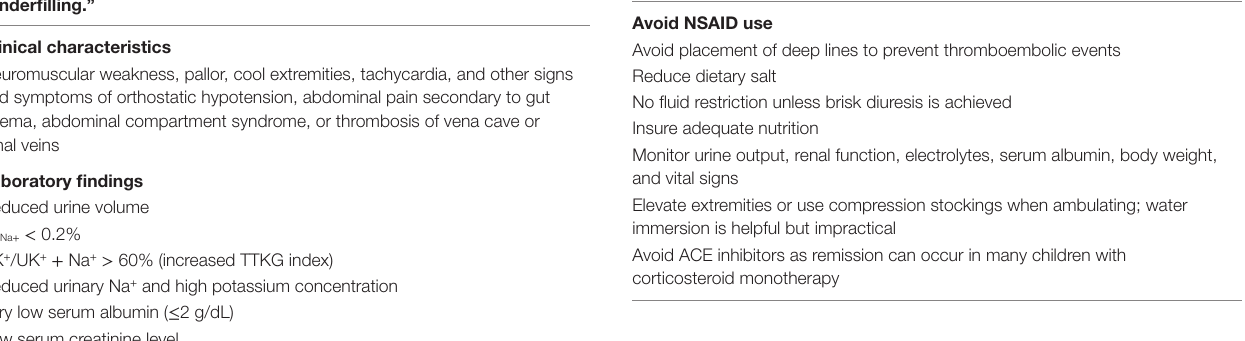
TABLe 4 | General aspects of management of edema in children with NS. TABLe 2 | Mechanism of edema formation in nephrotic syndrome: